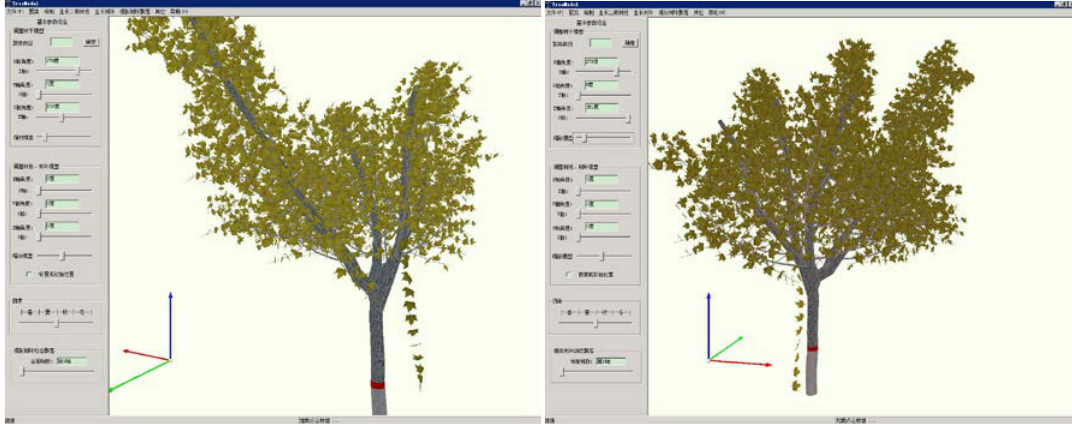
Figure 5. Two angles of the rotation falling with straight line